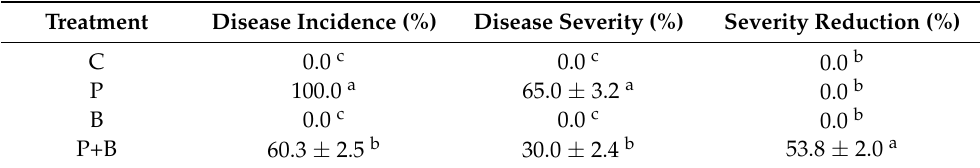
Table 2. Effect of Bacillus subtilis SR22 application on disease severity and incidence of tomato plants infected with Rhizoctonia root rot at 45 dpi *.